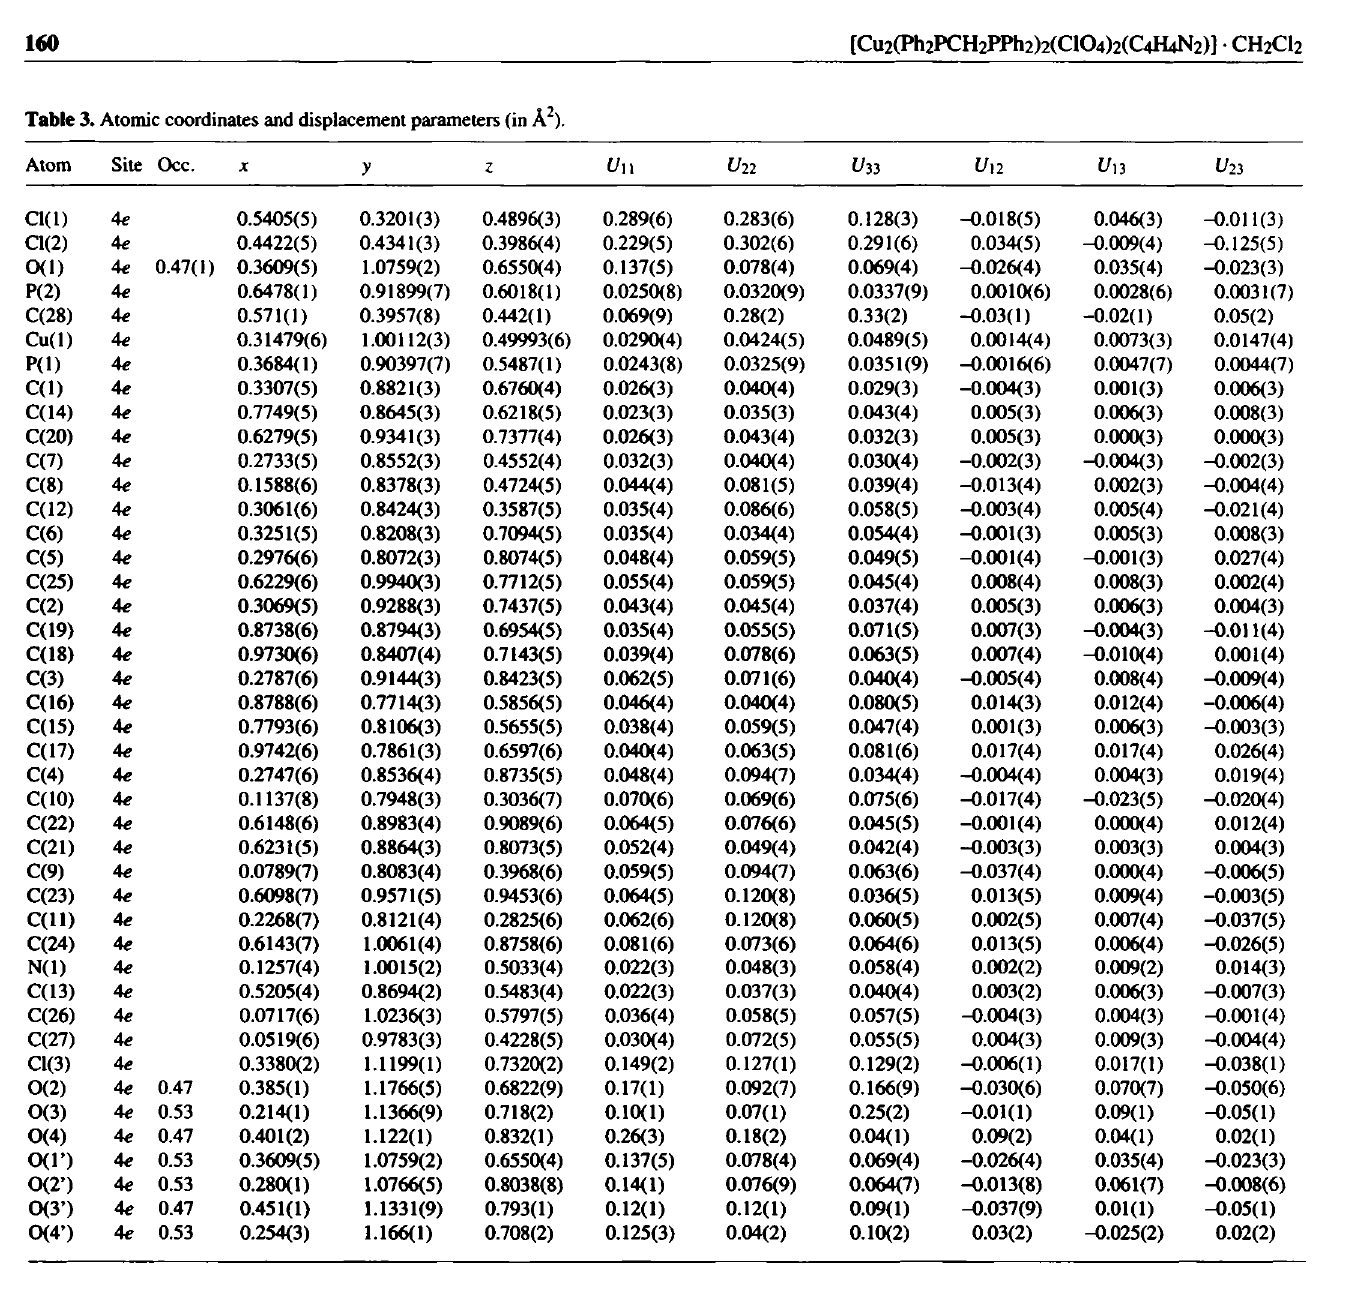
Table 3. Atomic coordinates and displacement parameters (in Â 2 ). Atom Site